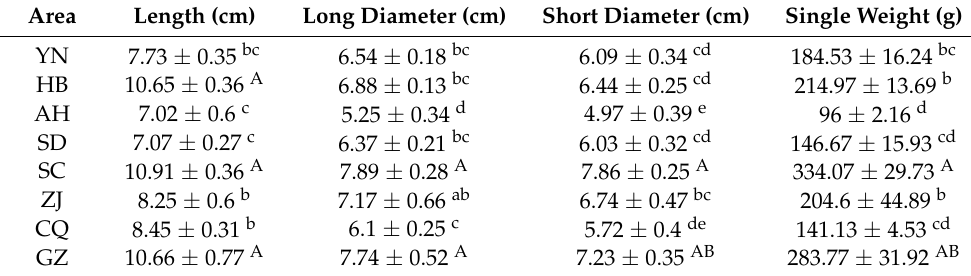
Table 1. Fruit dimensions of C. speciosa